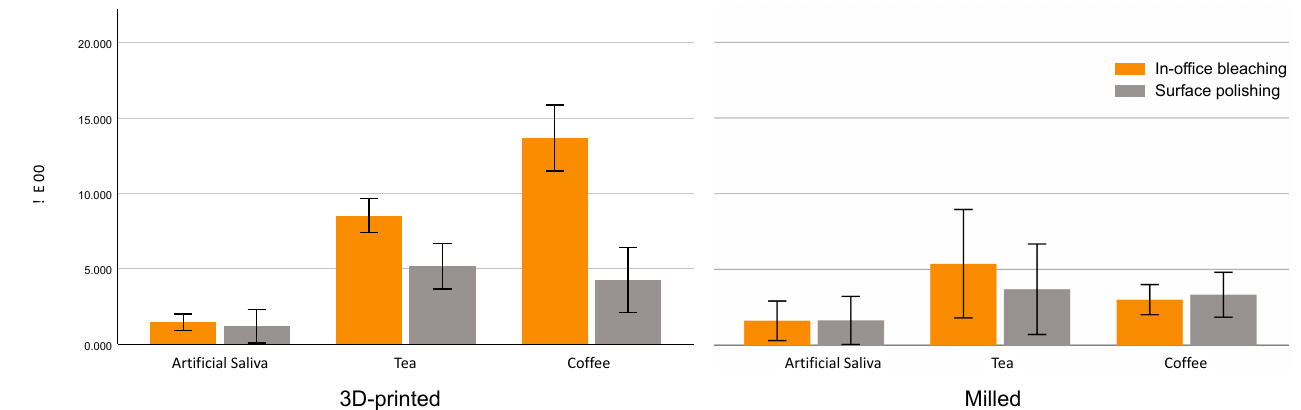
Figure 3. ∆ E 00 of stained milled and 3D-printed specimens after in-office bleaching and polishing techniques after immersion in coffee, tea and artificial saliva.